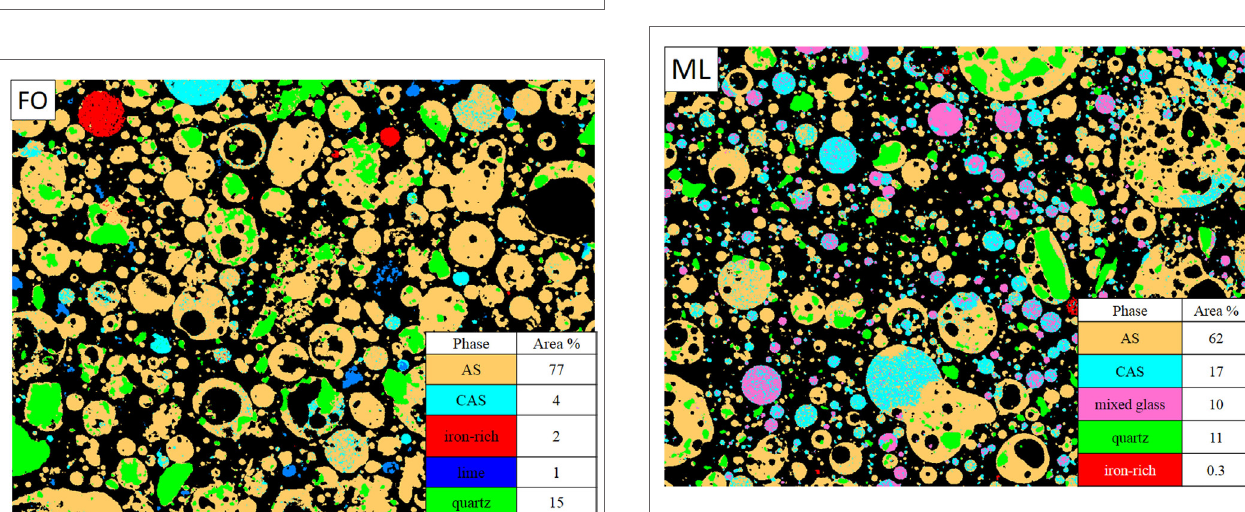
FigUre 3 | Phase assignment image of cc fly ash.